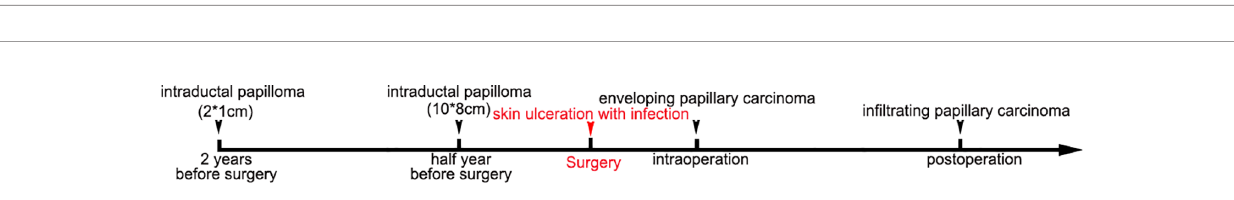
FIGURE 2 | Pathological photographs of the patient. (A) Postoperative pathological photograph of the breast. (B) Postoperative pathological photograph of the axillary lymph nodes.